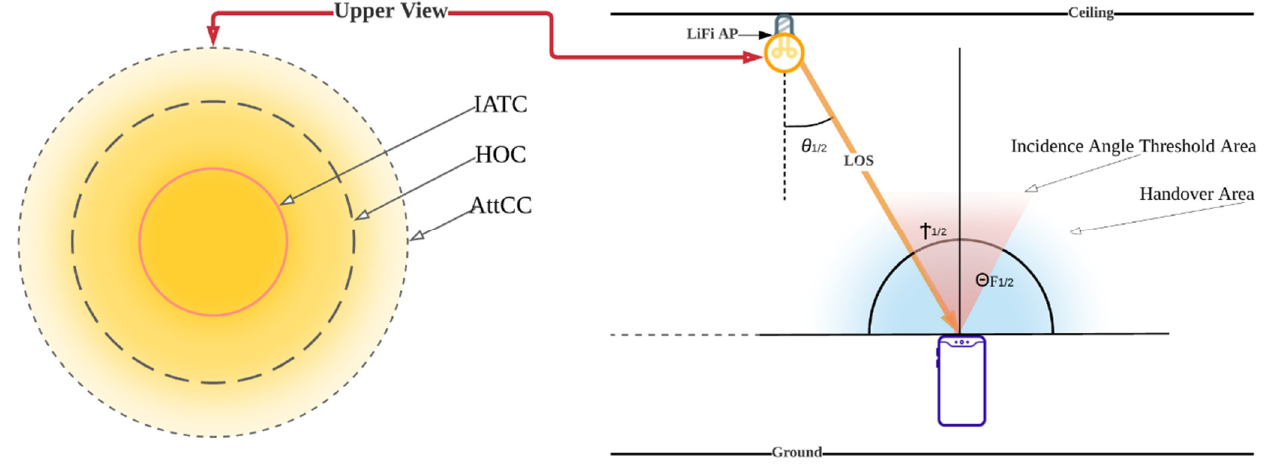
Figure 4. Illustration of the HOC inside the attocell with incidence angle threshold area IATC and AttCC. Table 2. Hardware specifications of the device used for the